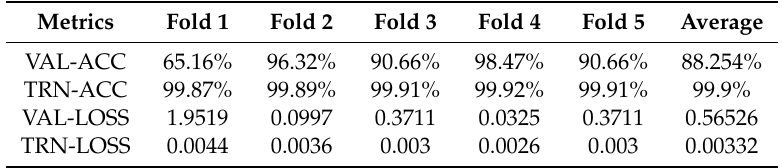
Table 3. Accuracy and loss scores for the binary-classification experiment (Exp#2) with the detailed results of each fold of the cross validation.